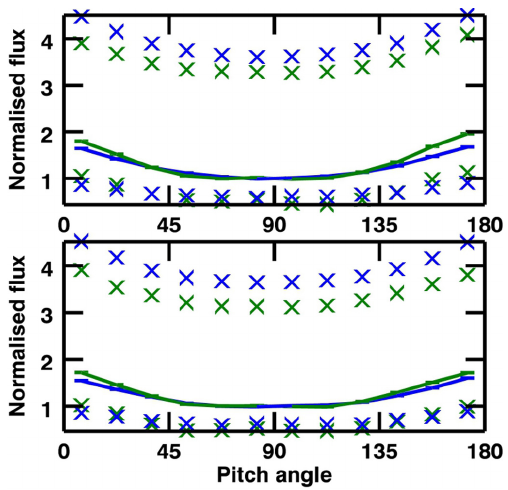
Fig. 3. Median electron differential energy flux for each of the 12 pitch angle bins, normalized to the average of the 75 ◦ − 90 ◦ and 90 ◦ − 105 ◦ pitch angle bins. Green line: Inflow region median, blue line: Outflow region median, green crosses: Inflow first and third quartiles, blue crosses: Outflow first and third quartiles. (a) Cluster spacecraft 1. (b) Cluster spacecraft